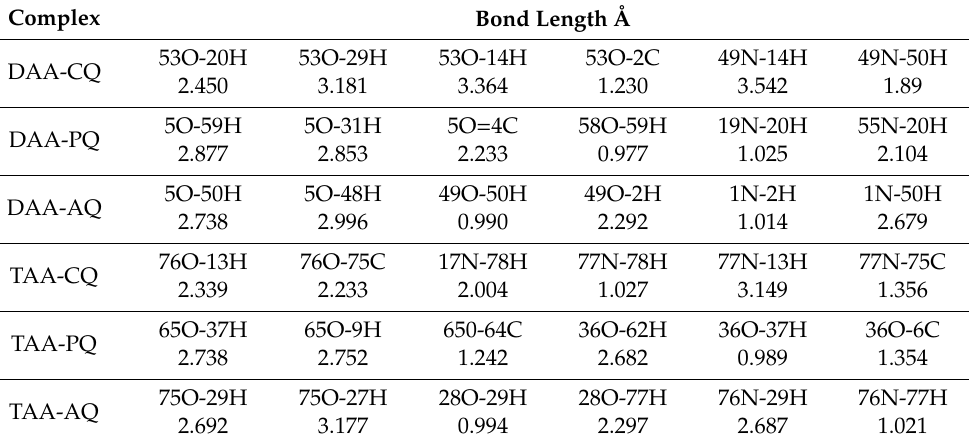
Geometry parameters for complexes DAA-CQ, DAA-PQ and DAA-AQ at wb97xd / 6-31 ++ G(d,p).